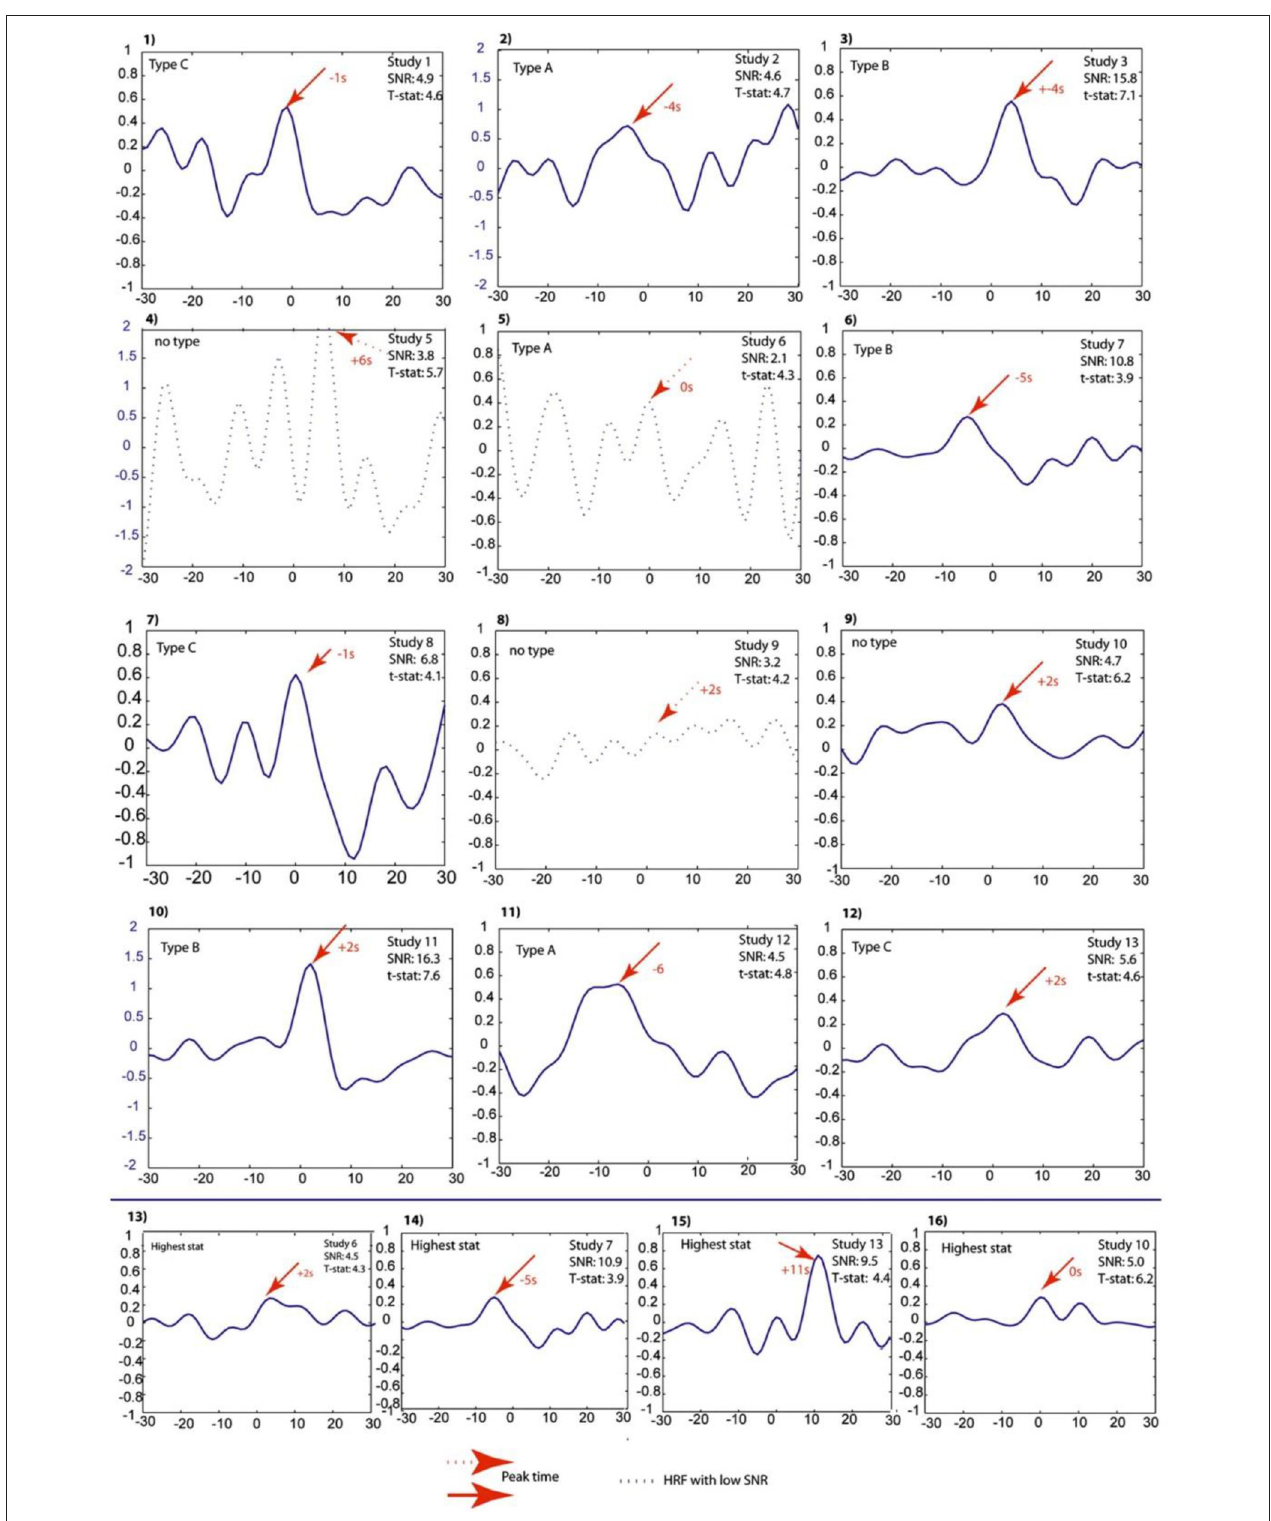
FIGURE 4 | Projected HRFs illustrated according to a sequence of patients. The bottom row shows HRFs calculated over the area with the highest t-statistic. The HRFs which presented with dotted lines are those that did not pass the SNR criterion of 4.5. The Blue scales had to be adjusted to obtain visibility of the HRF and thus differ from the rest. The HRF shape differences and their sporadic early peak times are obvious (54).